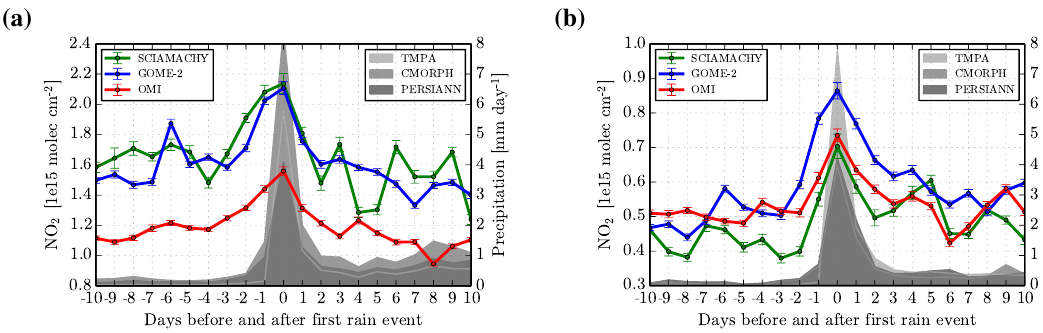
Figure 14. (a) NO 2 VCDs from SCIAMACHY, GOME-2 and OMI for south-western Africa in September–October–November around the first day of rainfall in this period. Precipitation is represented by the grey shaded areas. (b) Results for central Australia for the complete years